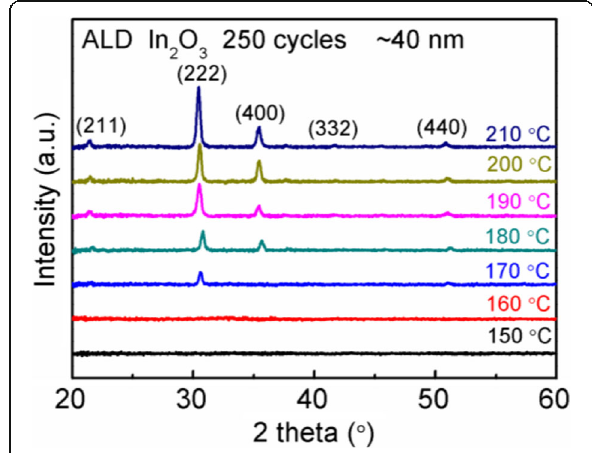
Fig. 2 X-ray diffraction patterns of the In 2 O 3 films deposited at different temperatures for 250 cycles